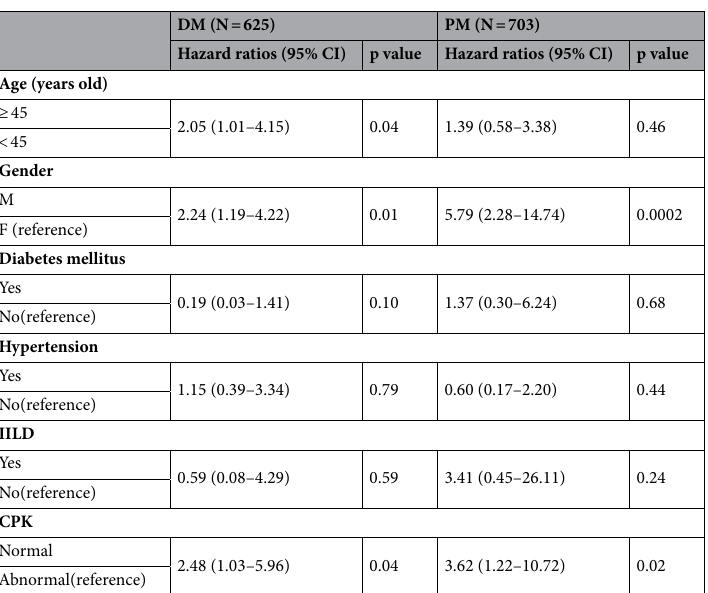
Table 4. Multivariate cox regression model analysis showed malignancy risk factors in patients with DM and PM. DM dermatomyositis, PM polymyositis, IILD idiopathic interstitial lung disease, CPK creatine phosphokinase, CI confidence interval.